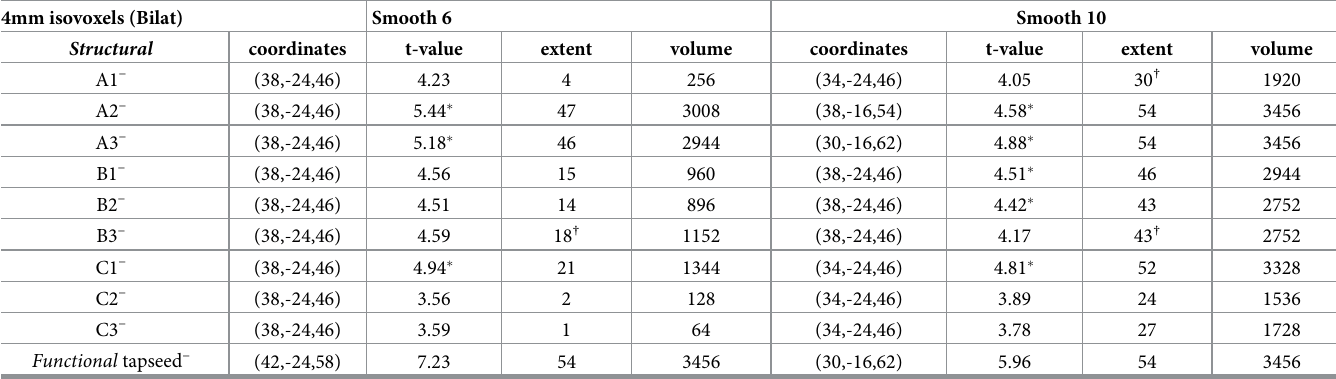
� Intensity threshold p < .05 after an additional FWE correction for evaluating 9 seed locations. † Extent threshold p < .001 after an additional FWE